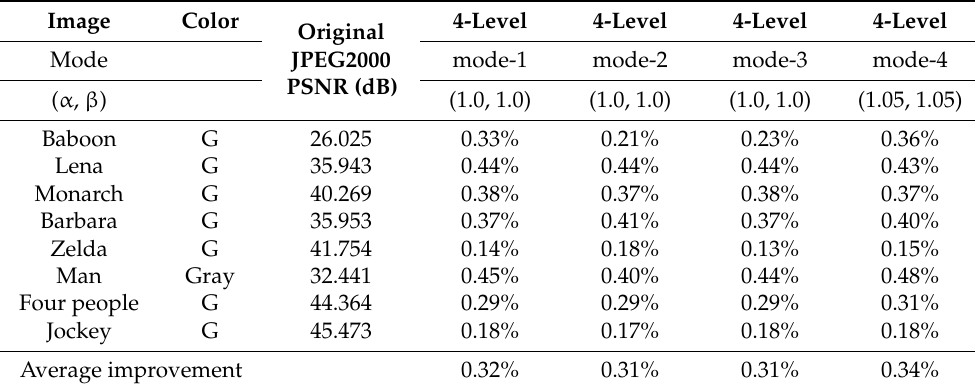
Table 20. Improvement percentage of PSNR (peak signal-to-noise ratio) with proposed algorithm applying multi-level MQ in JPEG2000 (lossy compression (compression ratio = 20:1), 4-level LUT MQ coder).